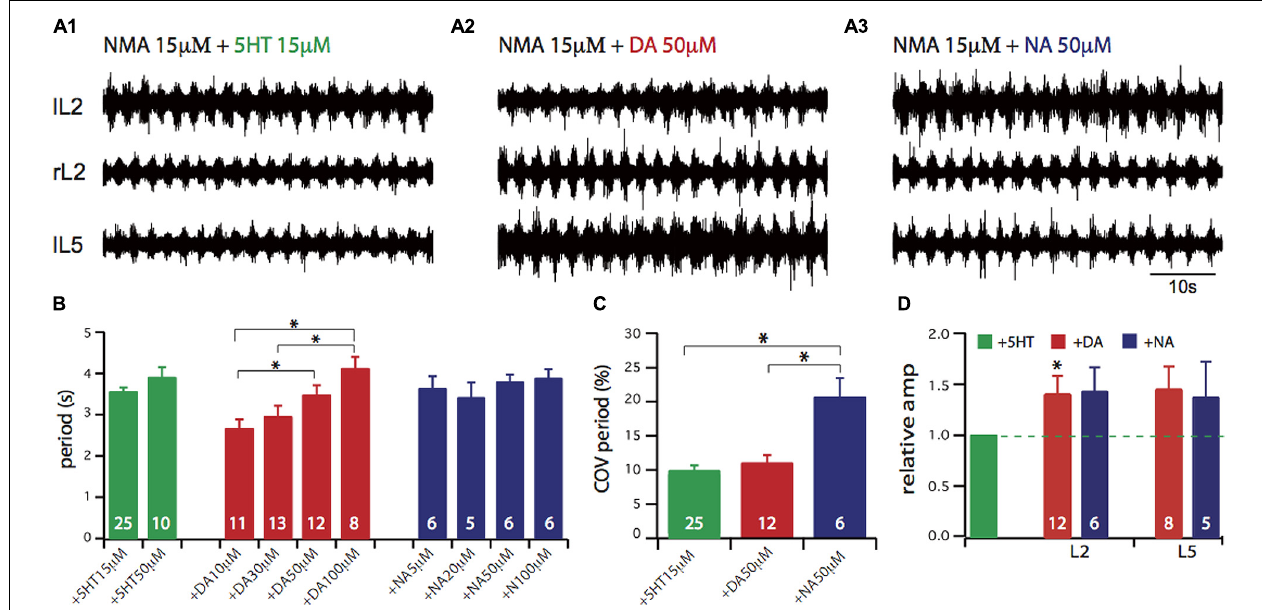
FIGURE 1 | Comparison of lumbar locomotor network activation in vitro by 5-HT, or DA or NA. (A) Each amine was added to the bathing saline containing the NMDA excitatory amino acid receptor agonist NMA (15 μ M), while extracellular recordings were made from the second left and right lumbar ventral root (lL2, rL2) and the fifth left lumbar ventral root (lL5) of the isolated spinal cord. (B) Plots of mean cycle period value obtained for different amine concentrations. A dose-dependent effect is only observable